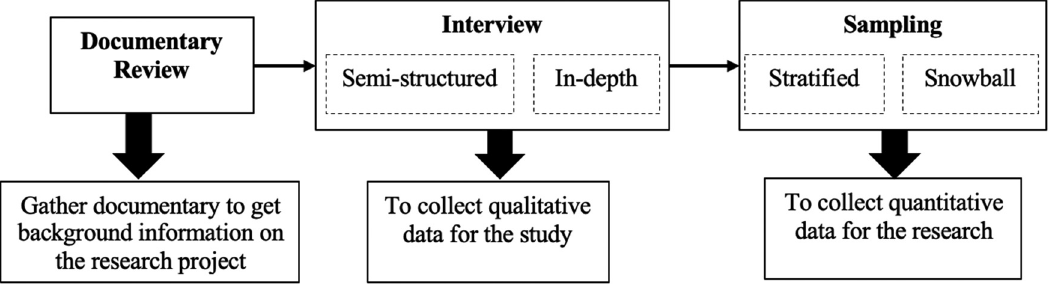
Figure 2: Sequence of study data